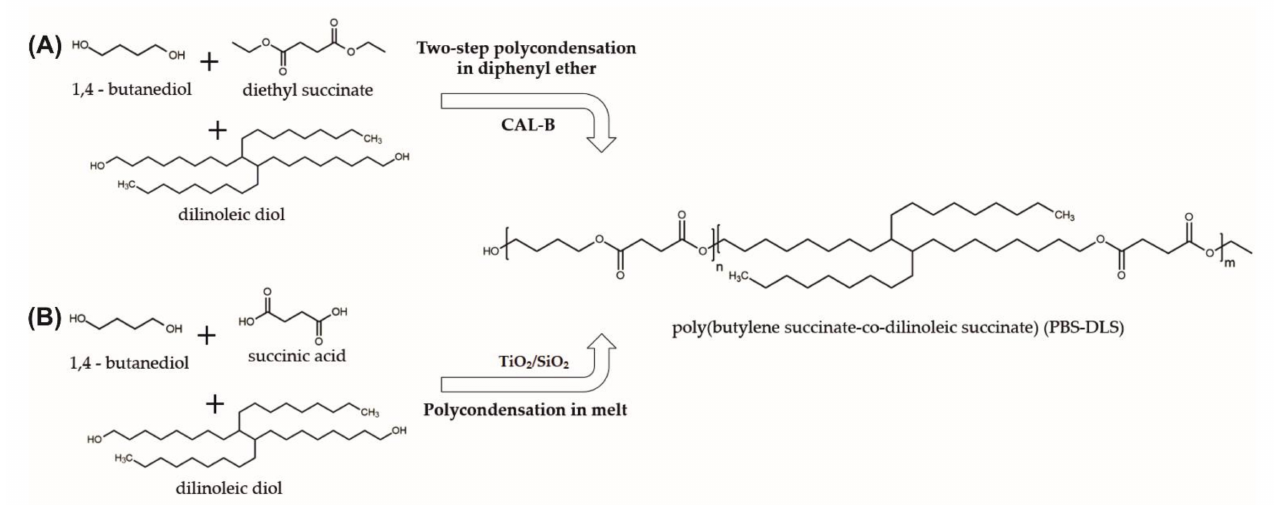
Figure 1. Synthesis of poly(butylene succinate-co-dilinoleic succinate) (PBS-DLS) copolymer via ( A ) two-step polycondensation in diphenyl ether using CAL-B and via ( B ) polycondensation in melt using TiO 2 /SiO 2 catalyst. (n—90, 70 or 50 wt% of hard segments; m—10, 30 or 50 wt% of soft segments).